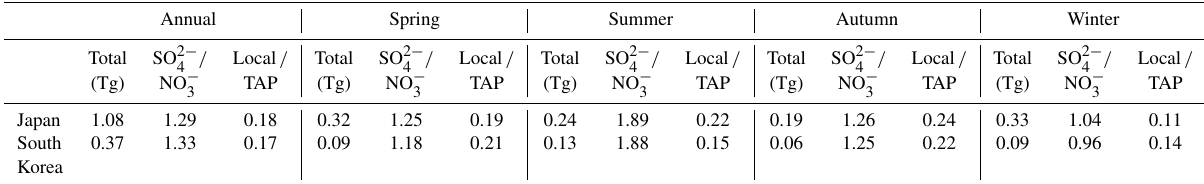
Table 7. Annual and seasonal acid deposition (SO 2 − (transboundary air pollution) contribution ratios.